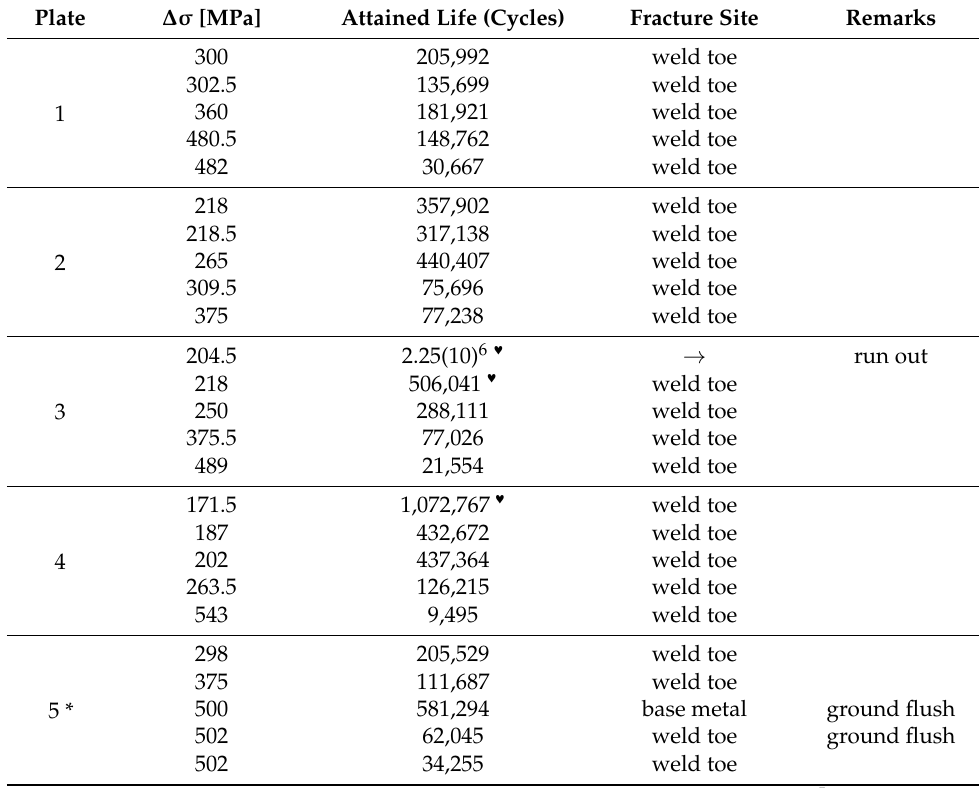
Table 3. List of standard 22MnB5 specimens with test condition and respective results. Plate ∆ σ [MPa] Attained Life (Cycles) Fracture